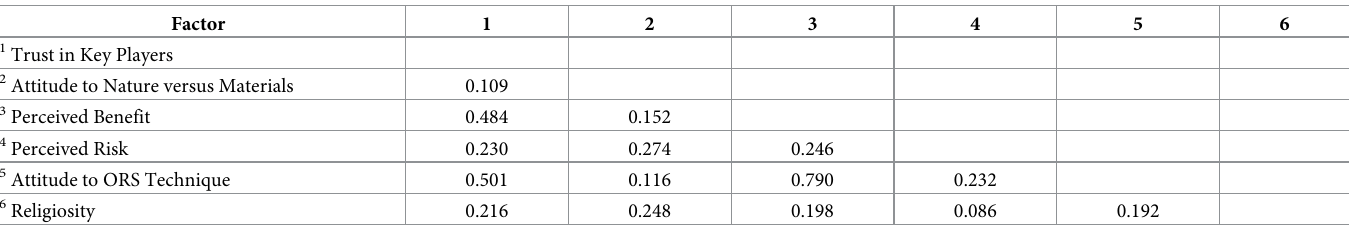
while the effect size of perceived risk and attitude to nature versus materials on perceived bene- fit was small (f 2 = 0.021). On the other hand, trust in key players (f 2 = 0.045) and attitude to nature versus materials (f 2 = 0.075) have a small effect size on the perceived risk. the ORS approach (0.287) were greater than zero which confirmed that the model’s predictive relevance was adequate for the exogenous variables [59, 65].